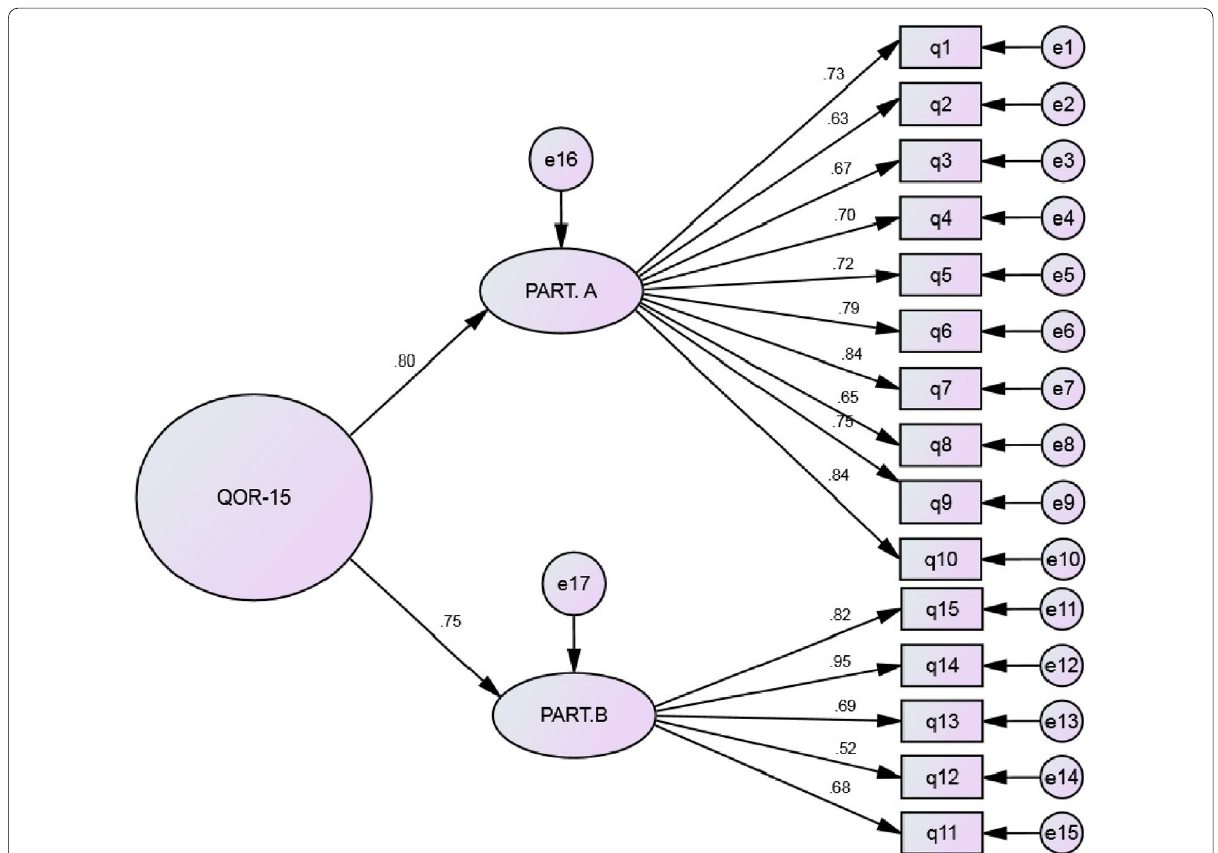
Fig. 3 QoR-15 questionnaire: model of second-order CFA